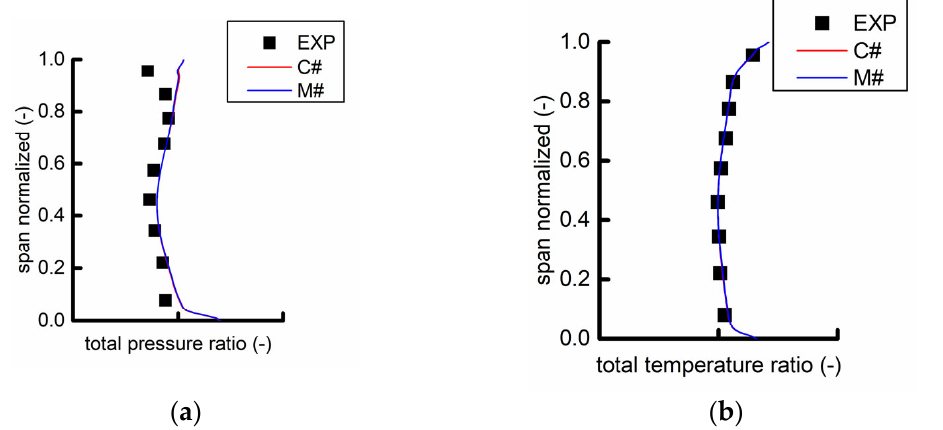
Figure 14. Circumferential force of R1 rotor blade. ( a ) Time domain ( b ) Frequency domain.